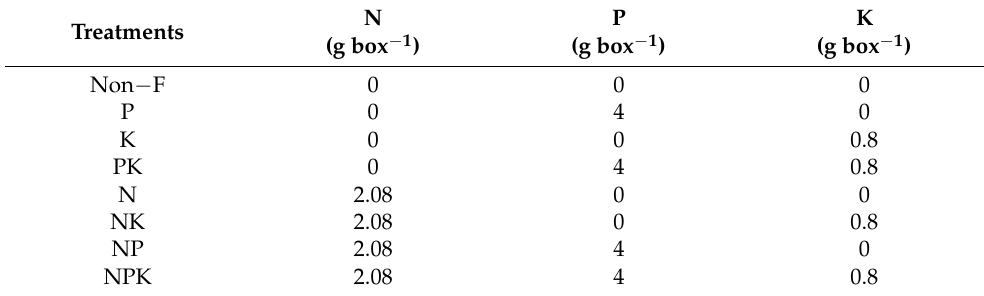
Table 1. The amount of N, P, and K fertilizers used in different treatments for the rhizo-box experiment.